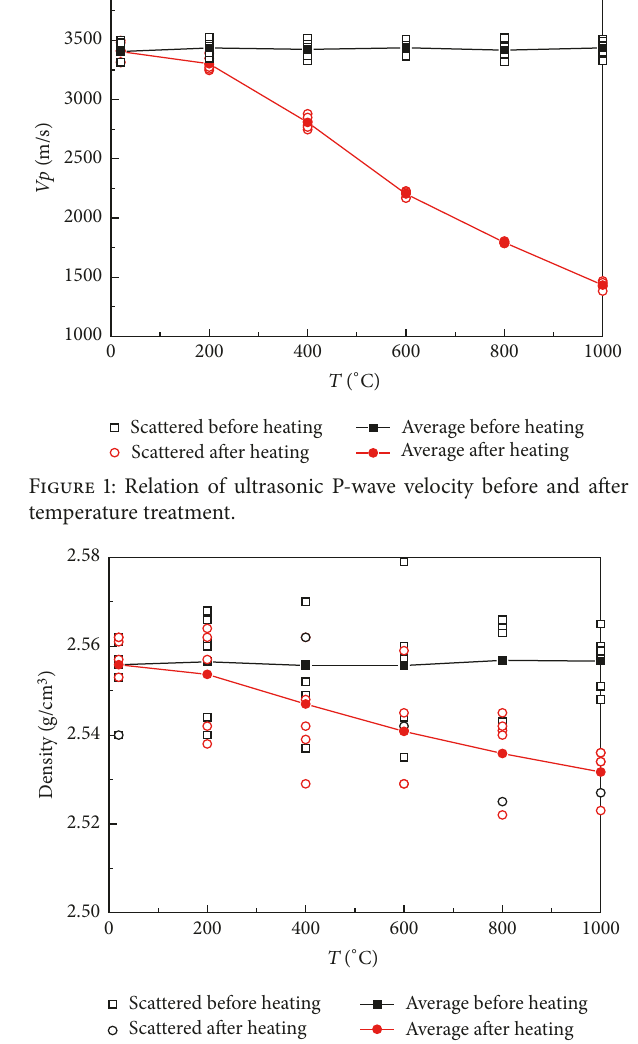
Figure 2: Variation of density versus temperature of